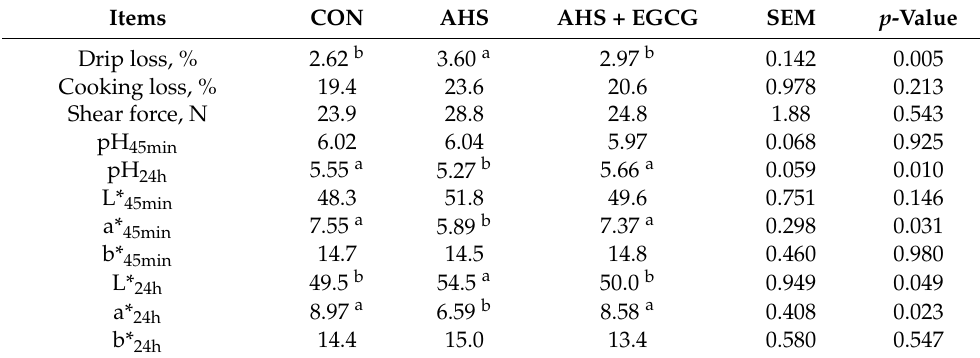
Table 4. Effect of EGCG on meat quality in the broilers subjected to acute heat